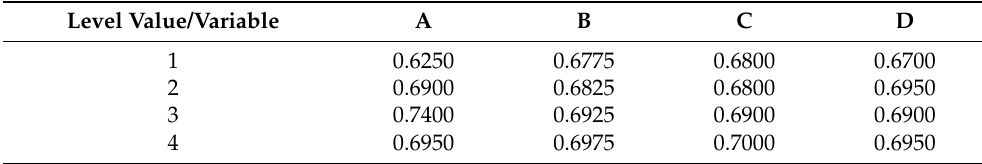
Table 7. Mean value of magnetic flux density for each variable at the horizontal